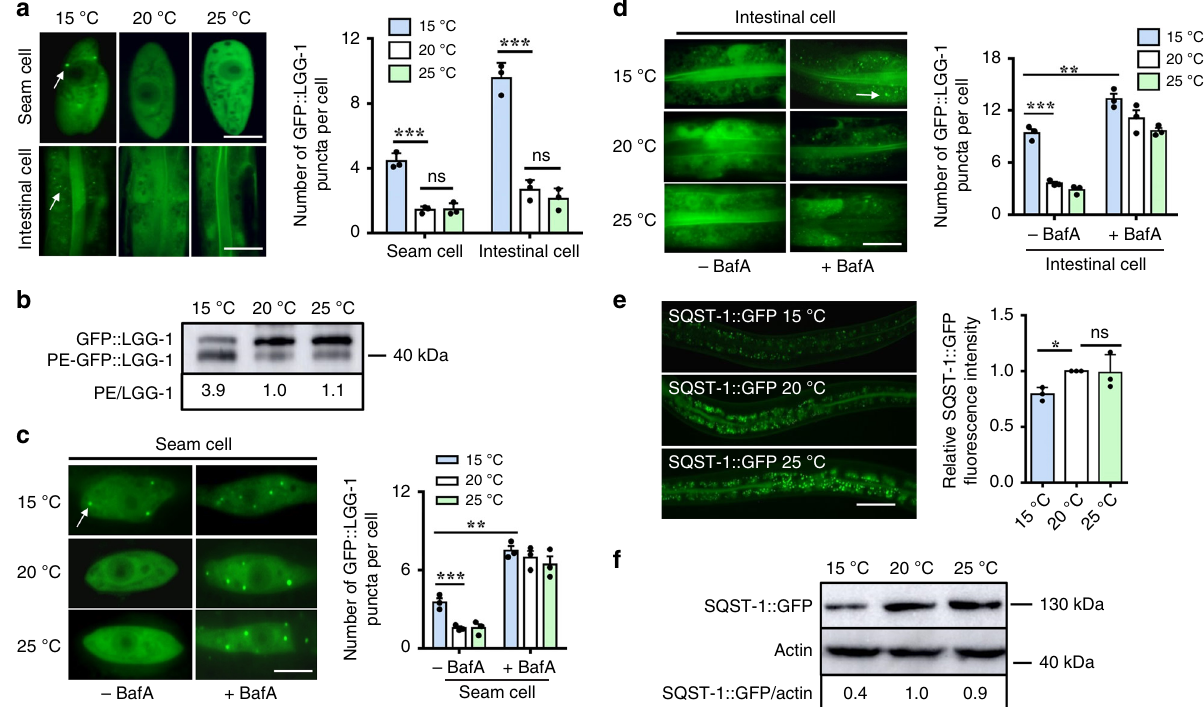
Fig. 1 Autophagic activity is elevated at low temperature in C. elegans . a Representative images of autophagosomes (GFP::LGG-1 puncta) in the seam cells and intestinal cells of day 1 worms grown at 15, 20, and 25 °C for 24 h, respectively. The arrow denotes a representative autophagosome. The numbers of GFP::LGG-1 puncta were counted. These results are means ± SD of three independent experiments ( n = 30 – 35 worms per experiment). *** P < 0.001, 15 °C versus 20 °C; ns, not signi fi cant. Scale bars: seam cells, 10 μ m; intestinal cells, 20 μ m. b The ratio of PE-GFP-LGG-1 to GFP-LGG-1 was measured by western blotting in worms. The blot shown here is typical of three independent experiments. These results are means± SD ( n = 3). P < 0.01, 15 °C versus 20 °C. c , d Quanti fi cation of GFP::LGG-1 puncta. After 1-day growth at 15, 20, and 25 °C for 24 h, adult worms were injected with 50 mM BafA or DMSO. Two hours after injection, GFP::LGG-1 puncta were quanti fi ed in seam cells ( c ) and intestinal cells ( d ), respectively. These results are means ± SD of three independent experiments ( n = 30 – 35 worms per experiment). ** P < 0.01; *** P < 0.001, 15 °C ( + BafA) versus 15 °C (-BafA); *** P < 0.001, 15 °C (-BafA) versus 20 °C (-BafA). Scale bars: seam cells, 10 μ m; intestinal cells, 20 μ m. e The expression of SQST-1::GFP in adult worms. The right panel shows quanti fi cation of GFP levels. These results are means ± SD of three independent experiments ( n = 50 – 55 worms per experiment). * P < 0.05, 15 °C versus 20 °C. Scale bars: 50 μ m. f The levels of SQST-1::GFP were measured by western blotting. The blot shown here is typical of three independent